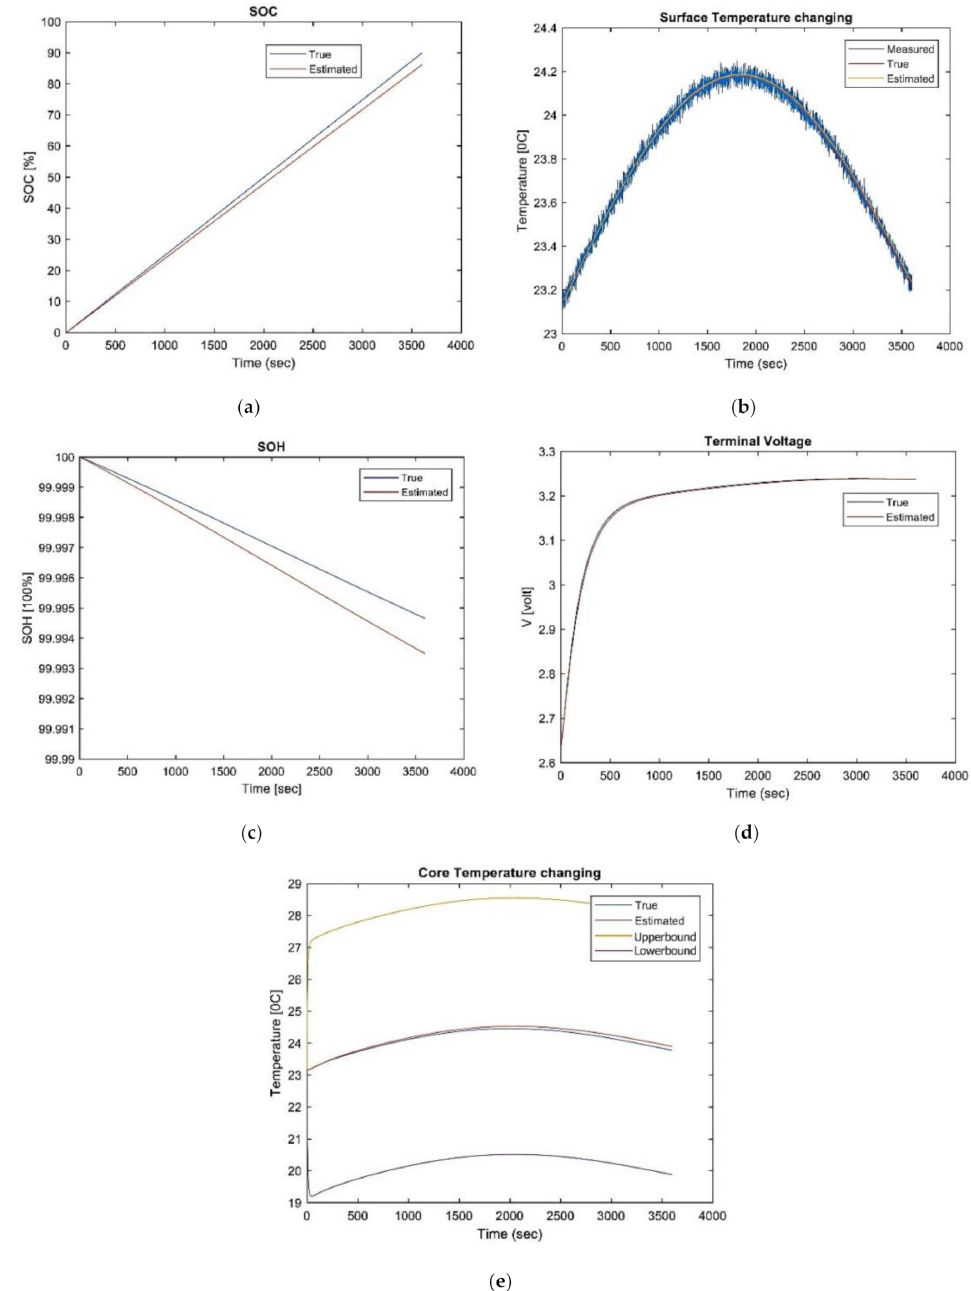
Figure 10. Temperature-measured observer estimation test using wrong parameters; ( a ) SOC, ( b ) service temperature changing, ( c ) SOH, ( d ) terminal voltage, ( e ) core temperature